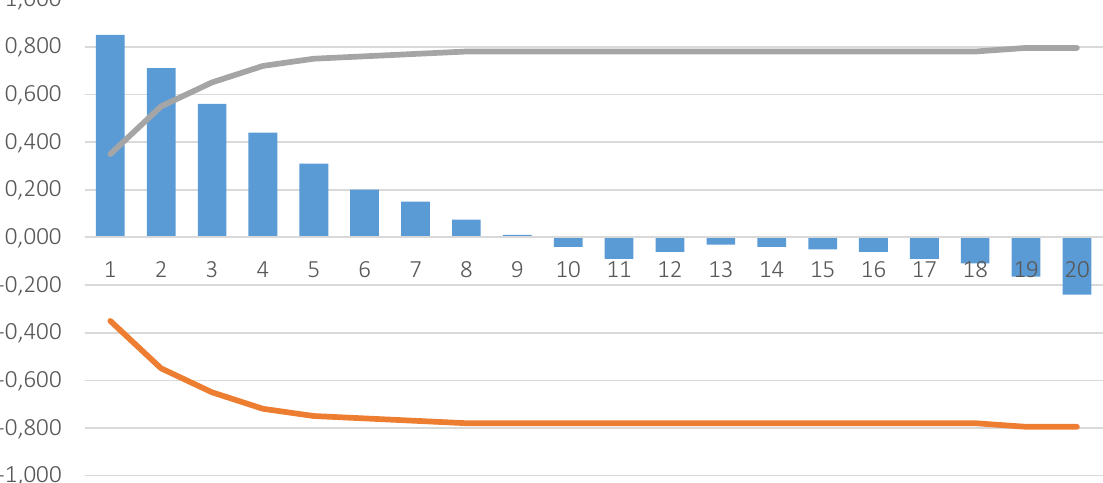
Figure 1. AFC daily